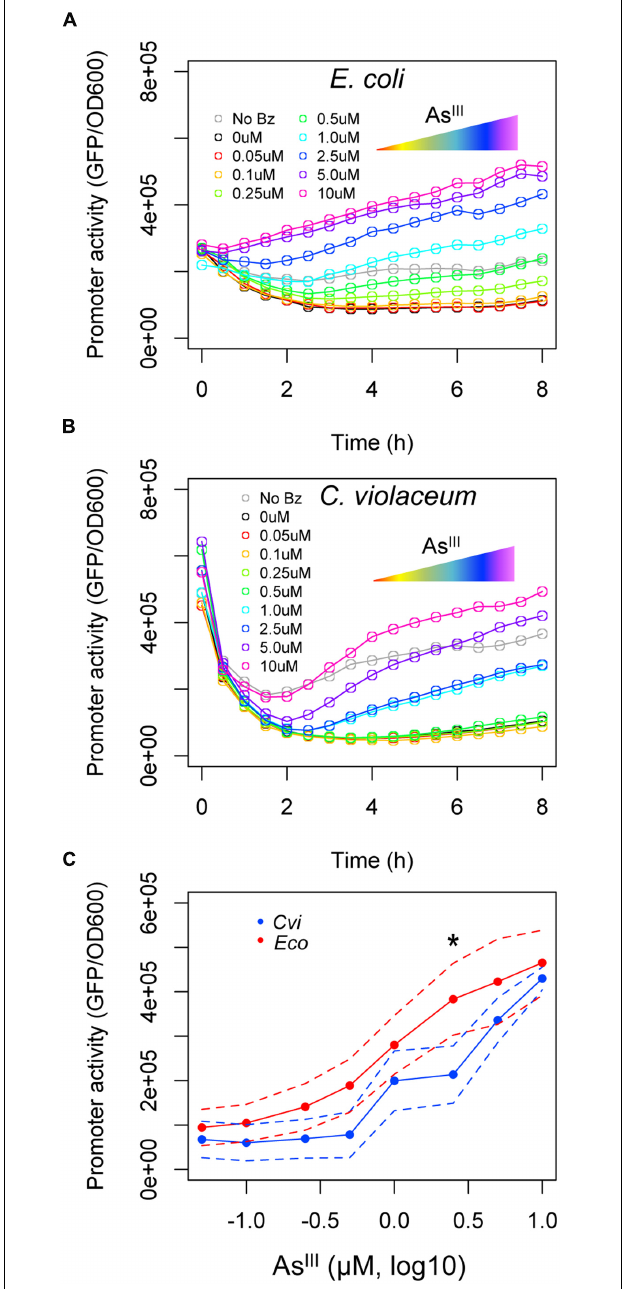
FIGURE 4 | Induction of ars systems with increasing concentrations of As III . E. coli AW3110 ( (cid:49) ars ) harboring the circuits represented in Figure 3A were exposed to a saturating concentration of benzoate (250 µ M) and varying concentrations of As III (from 0 to 10 µ M). (A) The expression profile of the ars system from E. coli induced with increasing concentrations of As III . (B) The expression profile of the ars system from C. violaceum induced with increasing concentrations of As III . (C) Induction kinetics of Pars cvi (blue) and Pars eco (red) upon exposure to increasing As III concentrations after 6 h of induction. Solid lines represent the average of three independent experiments, whereas dashed lines represents the upper and lower limits of standard deviations. Statistics differences are highlighted by ( ∗ ) as analyzed using Student’s t -test with p -value p <